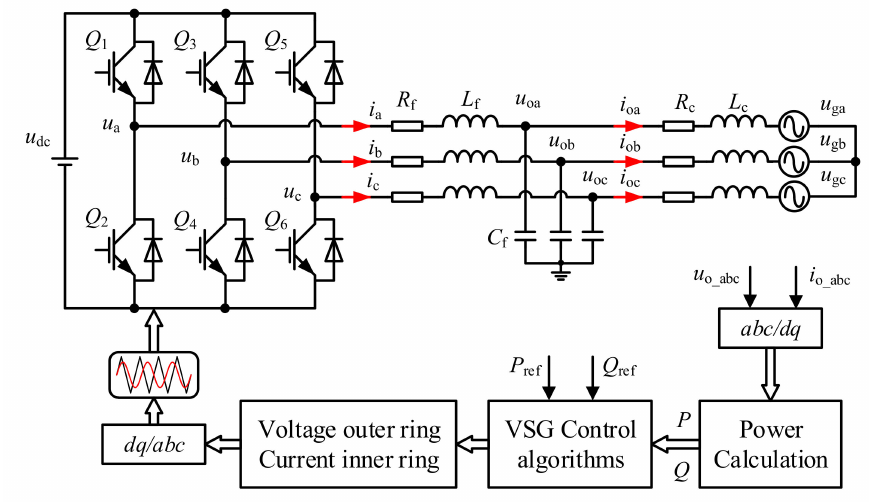
Figure 1. Topology diagram of VSG.